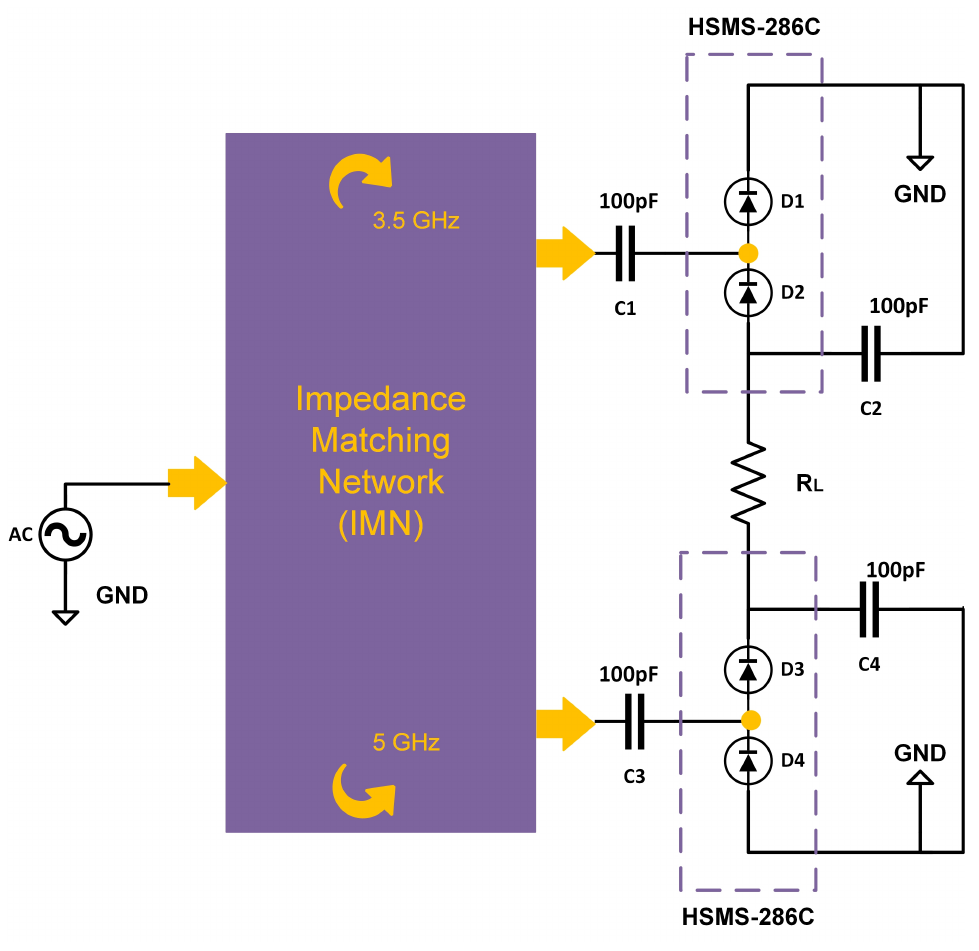
Figure 5. Proposed dual-band